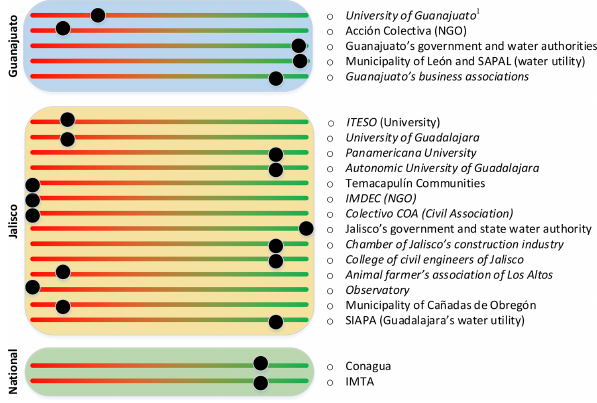
Figure 4. Position of key actors on a horizontal axis against (left, red) and in favor of (right, green) the Zapotillo dam project. New ac- tors are highlighted in italics (for more details on the figure method- ology and description of actors, see Table S2).